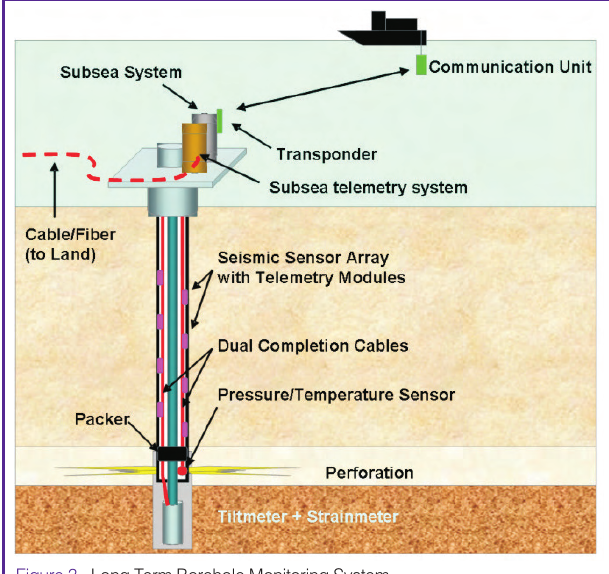
Figure 3. Long Term Borehole Monitoring